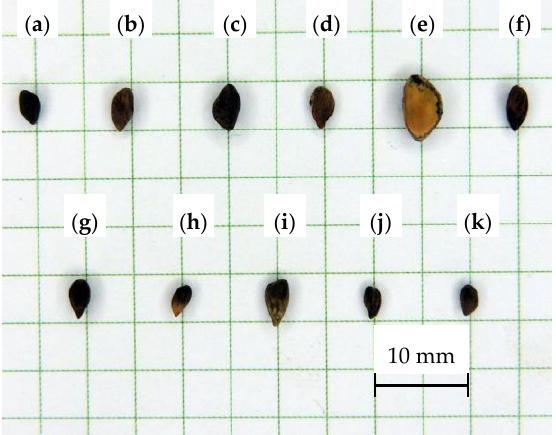
Figure 1. Seeds of: ( a ) blue spruce, ( b ) Jezo spruce, ( c ) Lijiang spruce, ( d ) Meyer’s spruce, ( e ) Morinda spruce, ( f ) Norway spruce, ( g ) oriental spruce, ( h ) red spruce, ( i ) Schrenk’s spruce, ( j ) Sitka spruce, ( k ) white spruce.